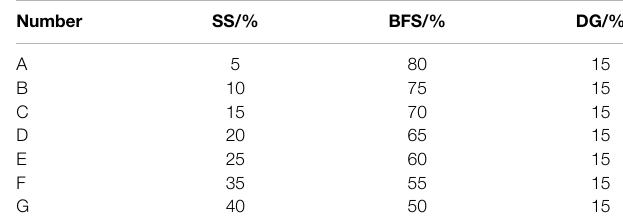
TABLE 2 | Cement mortar test scheme.